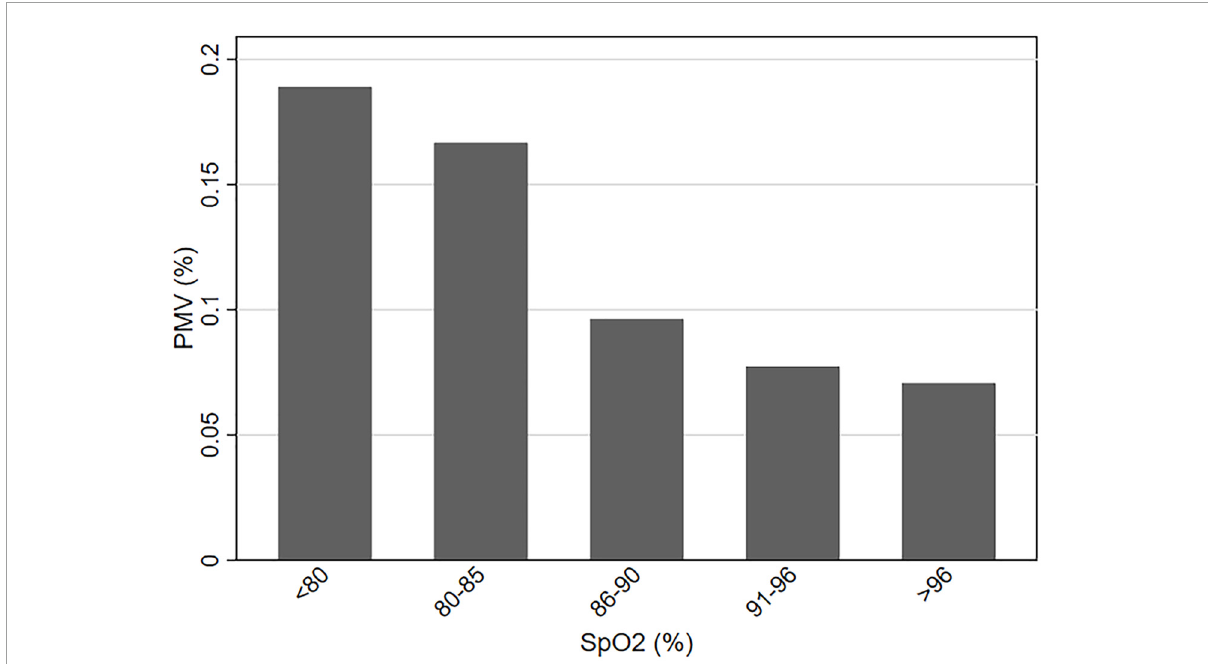
FIGURE2 The incidence of PMV at different levels of preoperative SpO 2 . PMV, prolonged mechanical ventilation; SpO 2 , pulse oximeter oxygen saturation.